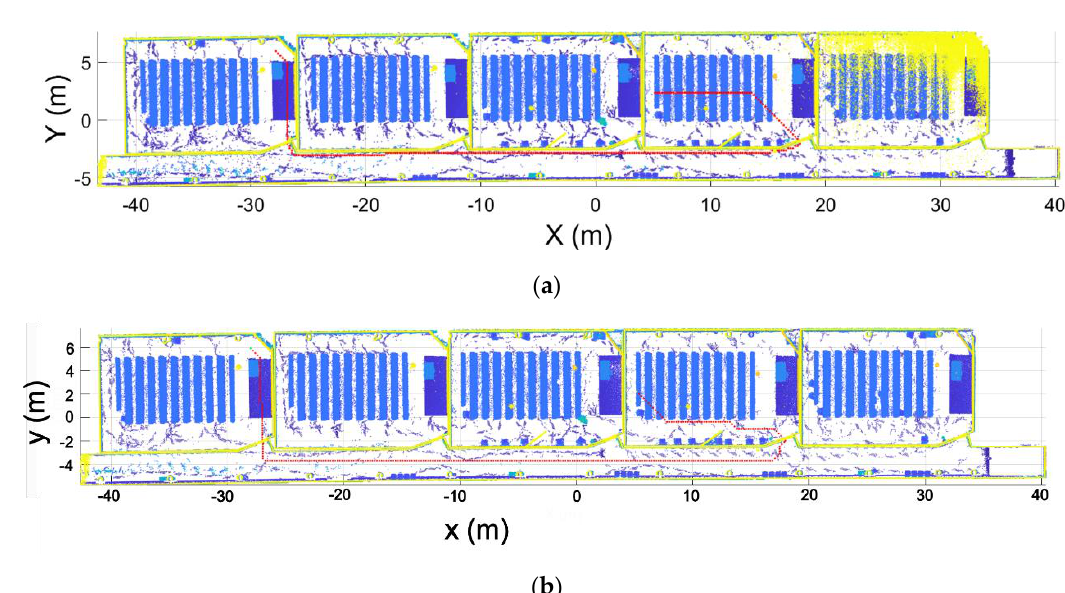
Figure 21. Routes (red dots) calculated between the same initial and final position. ( a ) Using an implementation of the A* path planning algorithm. ( b ) Using the modification of the A* path planning algorithm introduced in this manuscript.